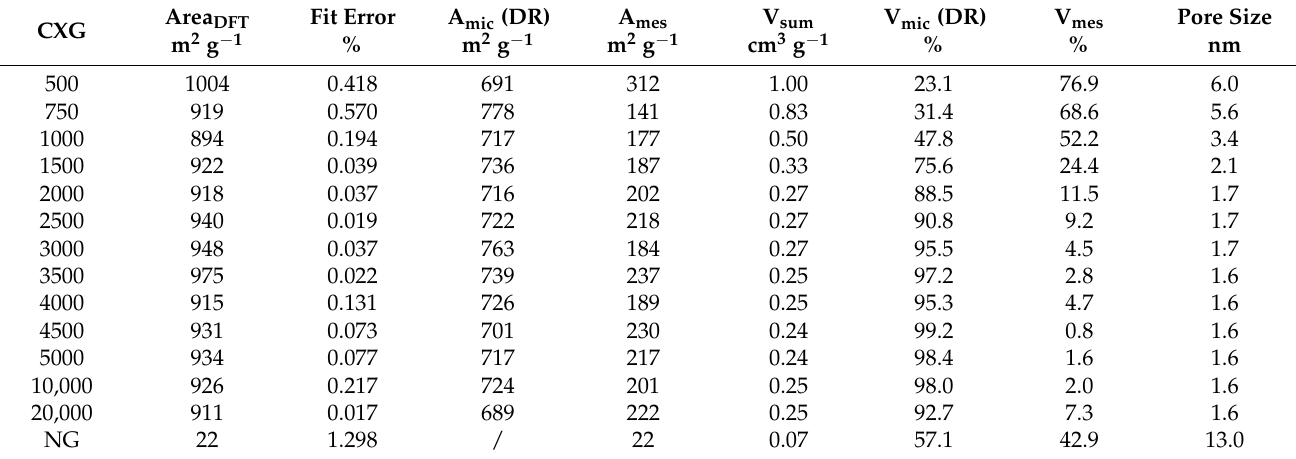
Table A2. Summary of physisorption measurements of carbon xerogels and natural